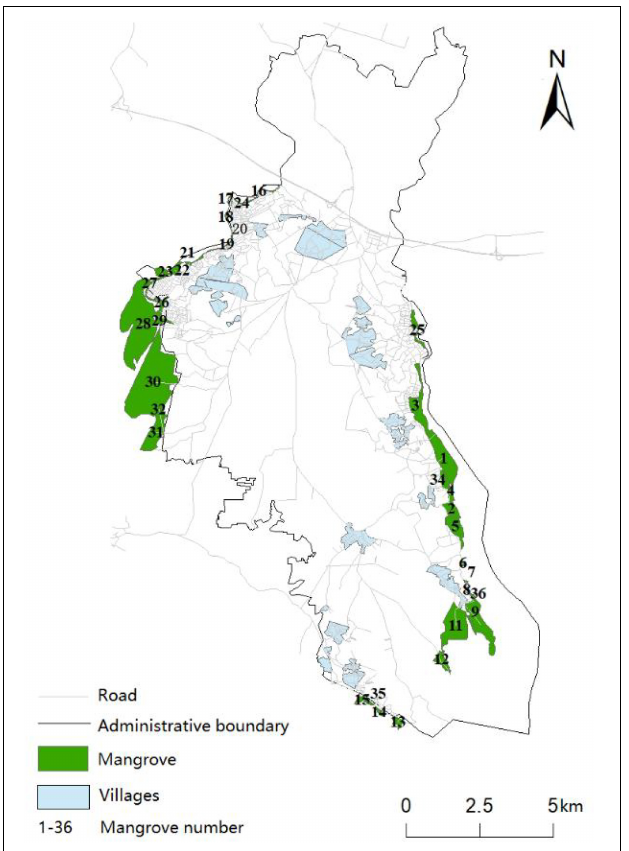
FIGURE 3 | Schematic diagram of mangrove